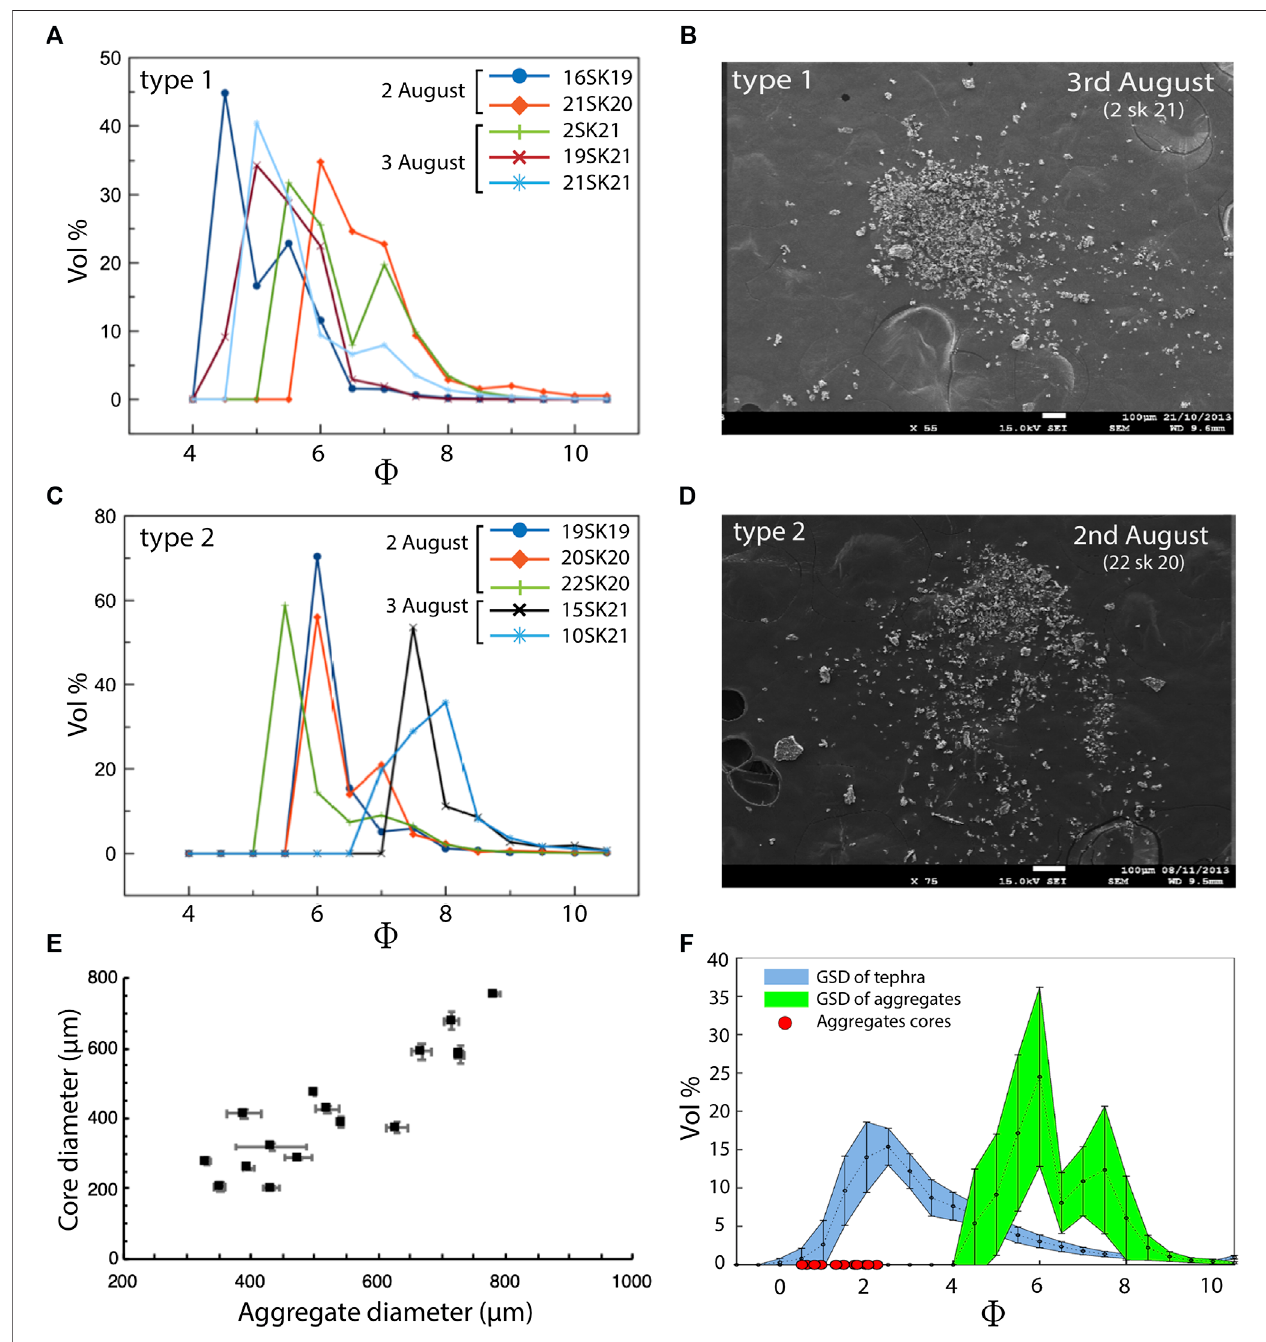
FIGURE 4 | Grain-size distributions of aggregates collected on August 2 – 3 are reported in different panels according to the type of distribution, together with representative SEM image of the associated coatings. (A – B) Type 1: GSD with high SP-ratio and low skewness; (C – D) GSD with low SP-ratio and high skewness; (E) aggregatesizecomparedwithsizeoftheassociatedcores;and (F) ComparisonbetweentheaverageGSDoftephra-falloutsamples(bluearea),andtheaverageGSDof aggregates (green area). The size of the measured aggregate cores is also reported (red dots).